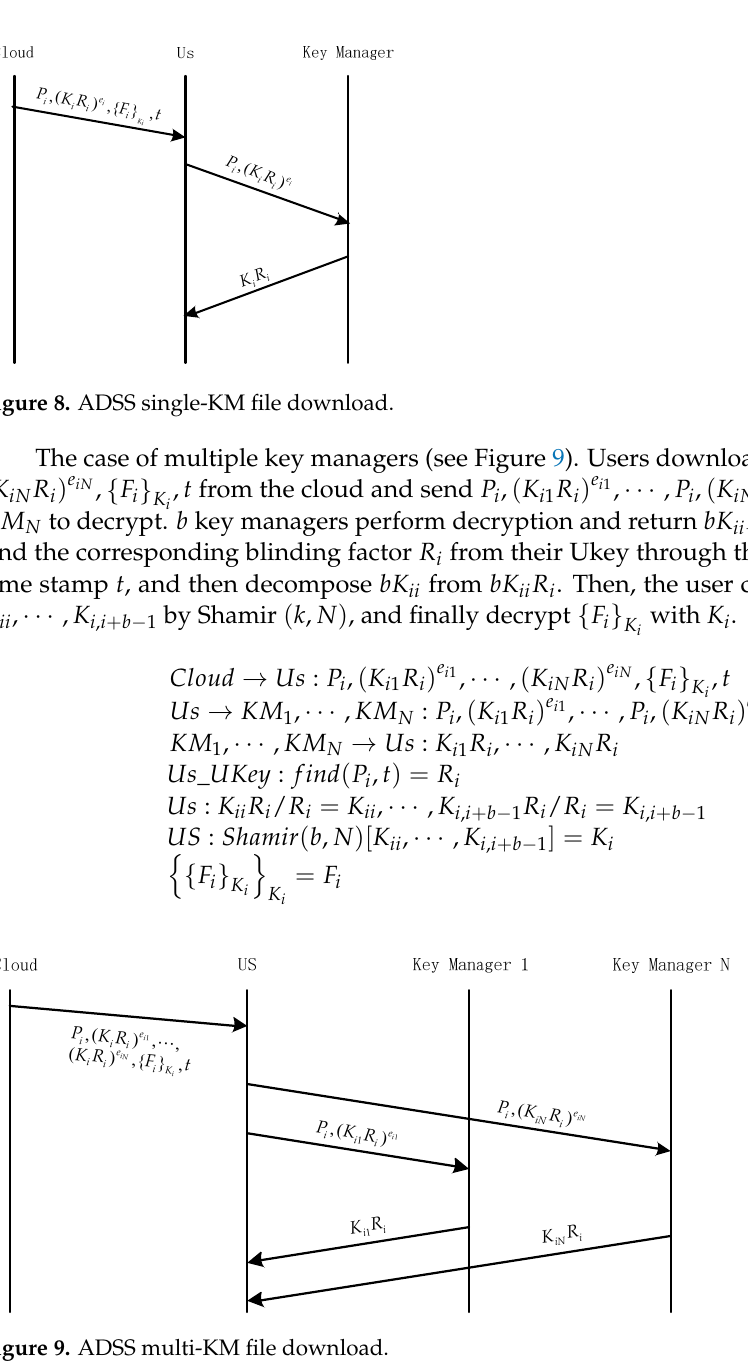
Figure 9. ADSS multi-KM file download.